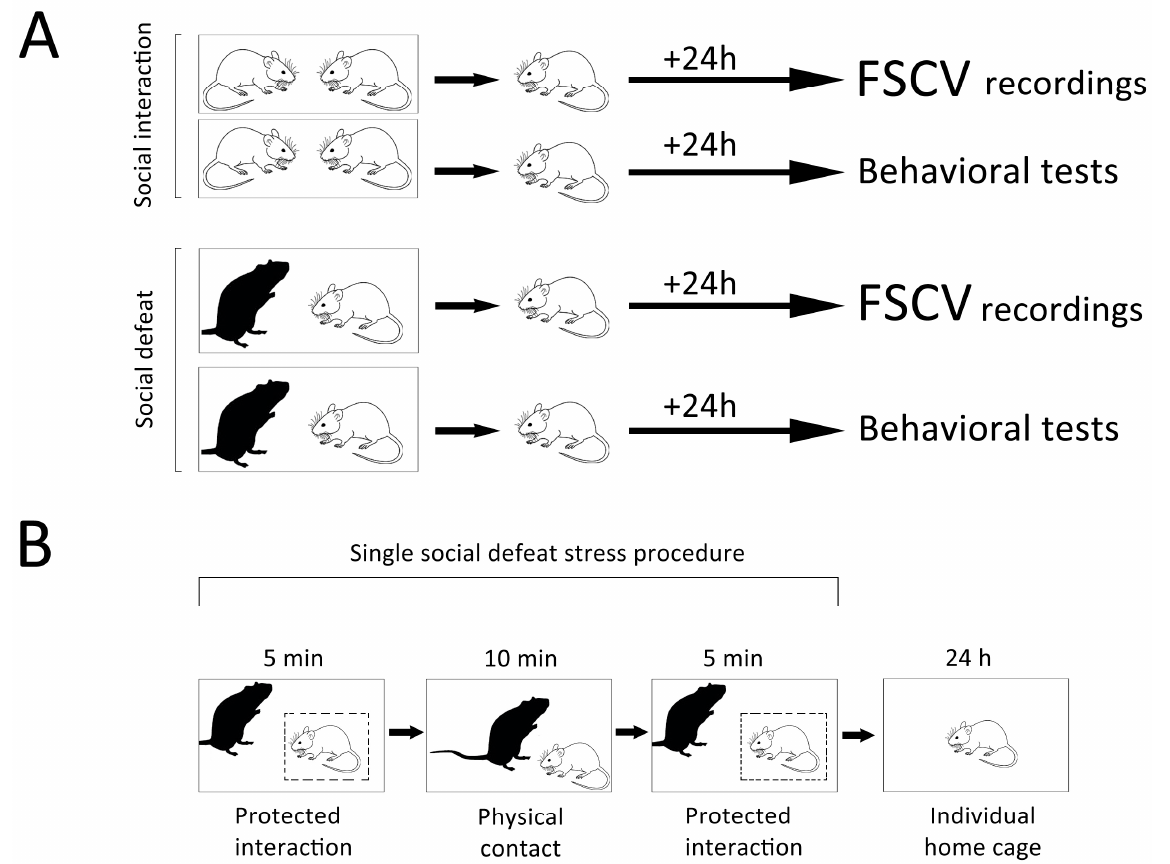
Figure 1. Schematic illustration of the experimental design. ( A ) Two groups of male Sprague Dawley rats (intruders) were exposed to different behavioral paradigms. In the first one (control condition), a subject was reintroduced to its cage mate (Sprague Dawley male), whereas in the second paradigm (social defeat), a rat was placed into the cage of an aggressive Long Evans male for the same period of time (20 min). 24 h after these procedures, intruders were subjected to either FSCV study or behavioral assessments (sucrose consumption, open field test and forced swim test). ( B ) During the first and last segments of the social defeat session, rats could interact through a wire mesh inset cage only. In the second segment of the paradigm, animals were allowed to physically contact with each other. Following this procedure, subjects were returned to their home cages for 24 h.